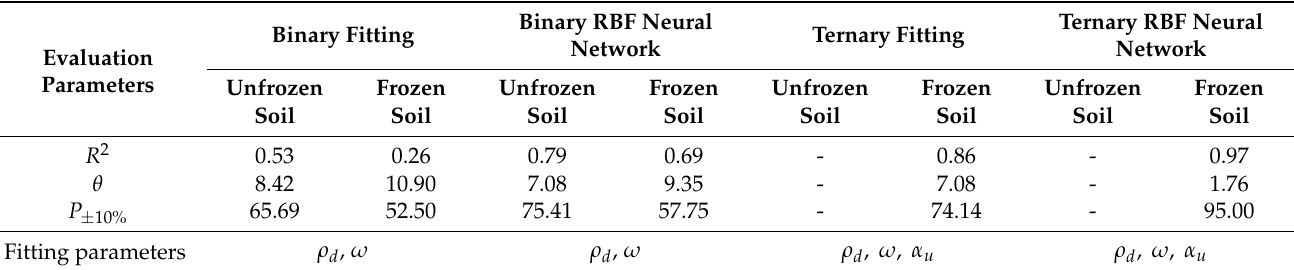
Table 5. Comparison of prediction results of different